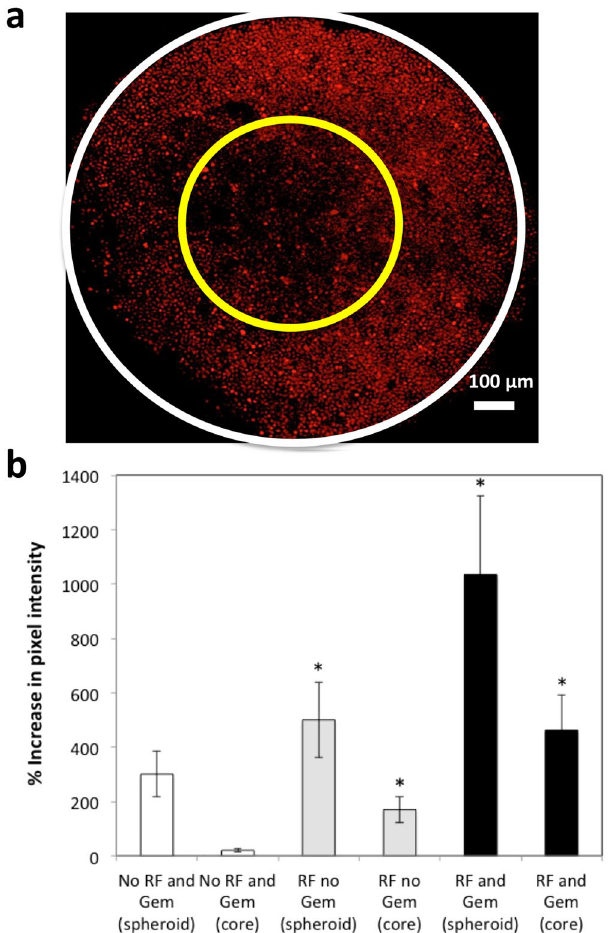
Figure 5. DRAQ7 signals denoting cell death induced by Gem through RF pretreated Capan-1 spheroids. ( a ) A representative spheroid image is shown. For the analysis, the center of the inner circle (enclosing the “core”) was positioned in the center of the spheroid (enclosed by the larger circle), with a radius half that of the whole spheroid. ( a ) Pixel intensity was quantified for whole spheroid (within outer circle) and for spheroid core (within inner circle). The regions of interest (ROI) were randomly selected. ( b ) Percent increase in DRAQ7 intensity for the whole spheroid and for the core, normalized to pixel intensity in the untreated group. Error bars represent standard deviation (n = 3). Statistical significance ( * ) determined using two-tailed Student’s t-test with significance level of